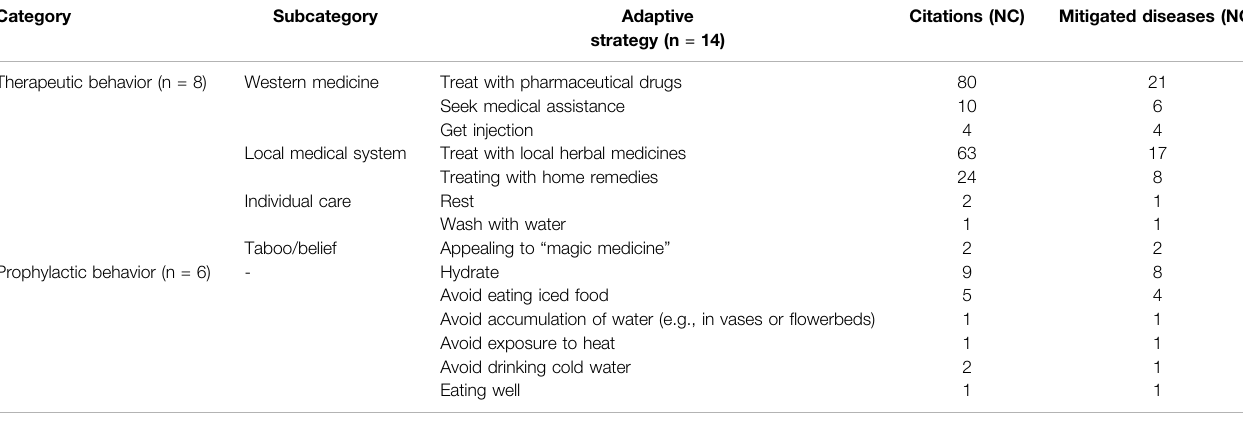
TABLE 5 | Adaptive strategies used to mitigate diseases perceived by farmers living in Carão, Pernambuco State, Northeastern Brazil.